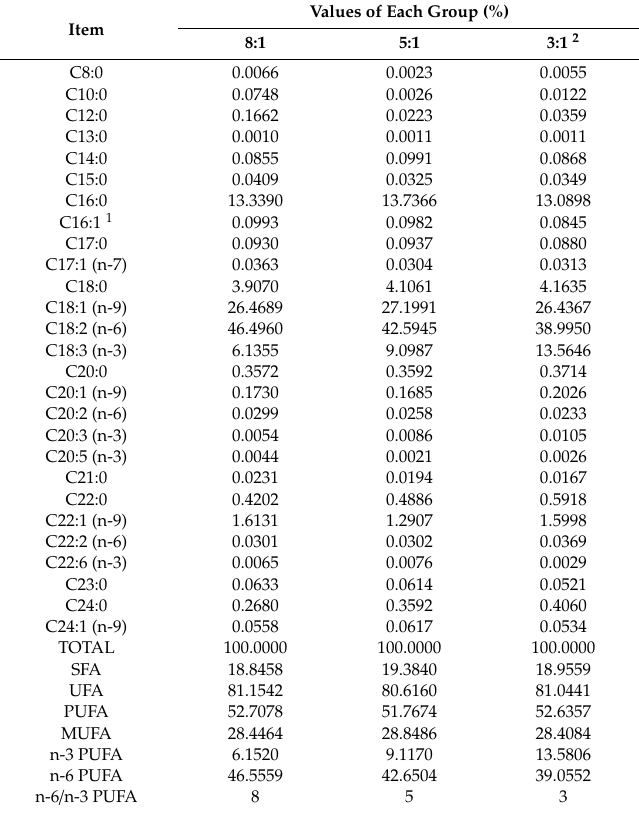
Table A1. Fatty acid profiles of